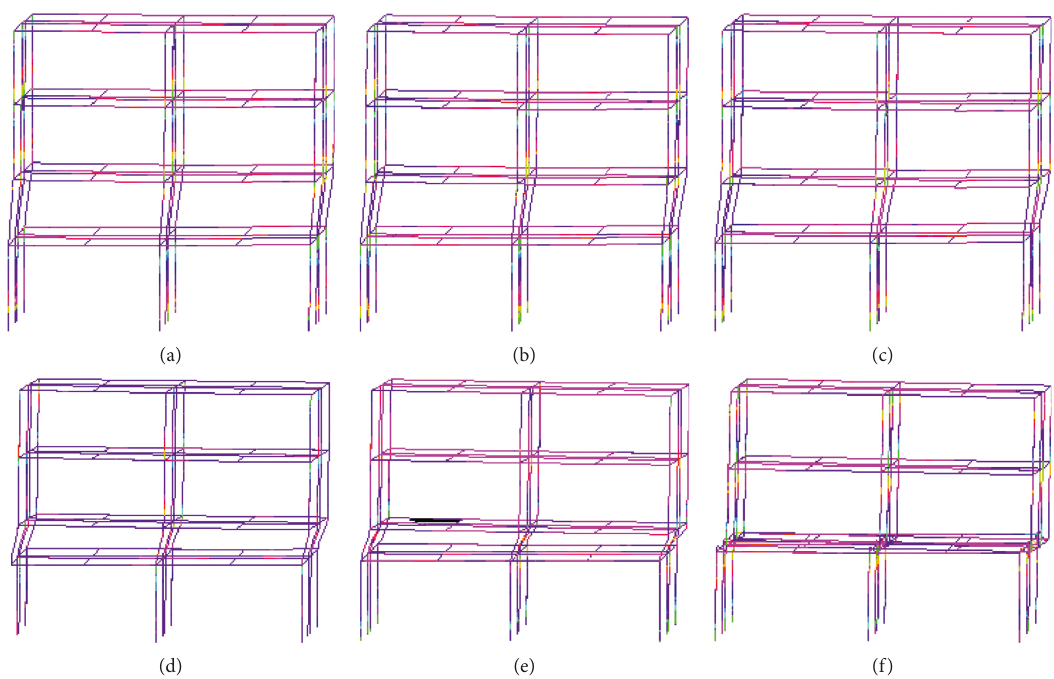
Figure 11: Collapse process of the structure subjected to three-component excitation under Tianjin wave. (a) t � 13.4s. (b) t � 13.5s. (c)